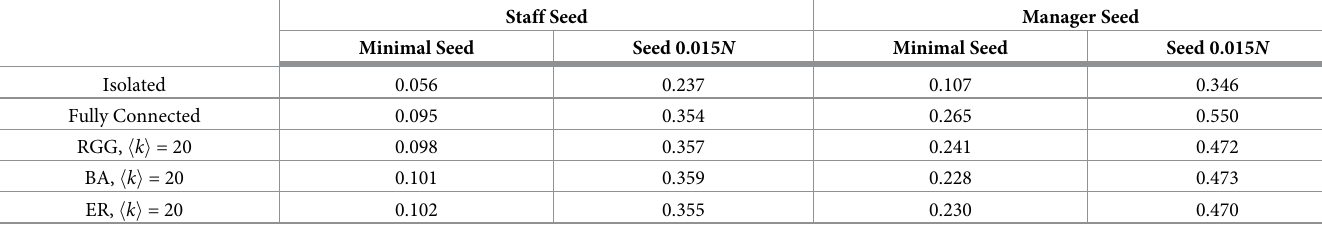
The average maximum adoption over 1000 runs on the synthetic network with various manager connection strategies. Average degrees of 20 were chosen for the management layer to match the base layer and the overall average of the empirical